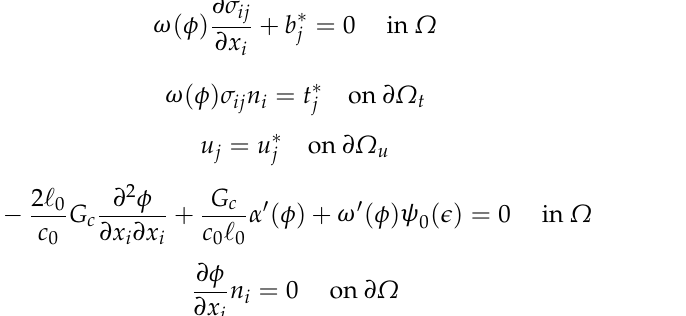
∂𝛺 (cid:3048) and tractions 𝒕 ∗ for ∂𝛺 (cid:3047) , respectively. The outward unit normal vector of external boundary